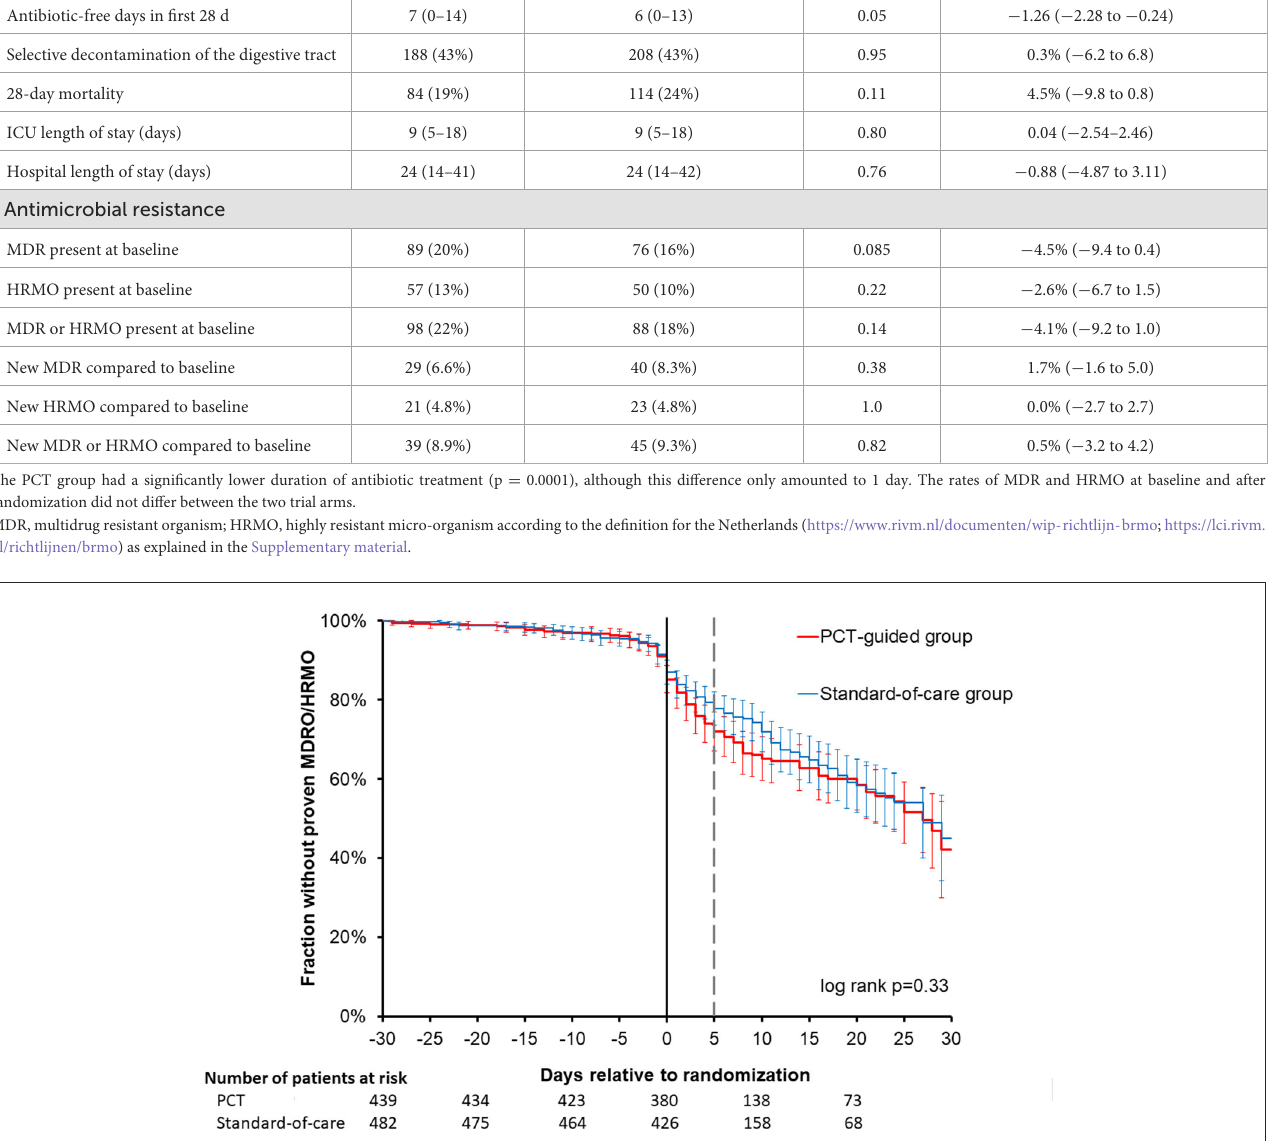
TABLE 2 Outcomes. Antibiotic use